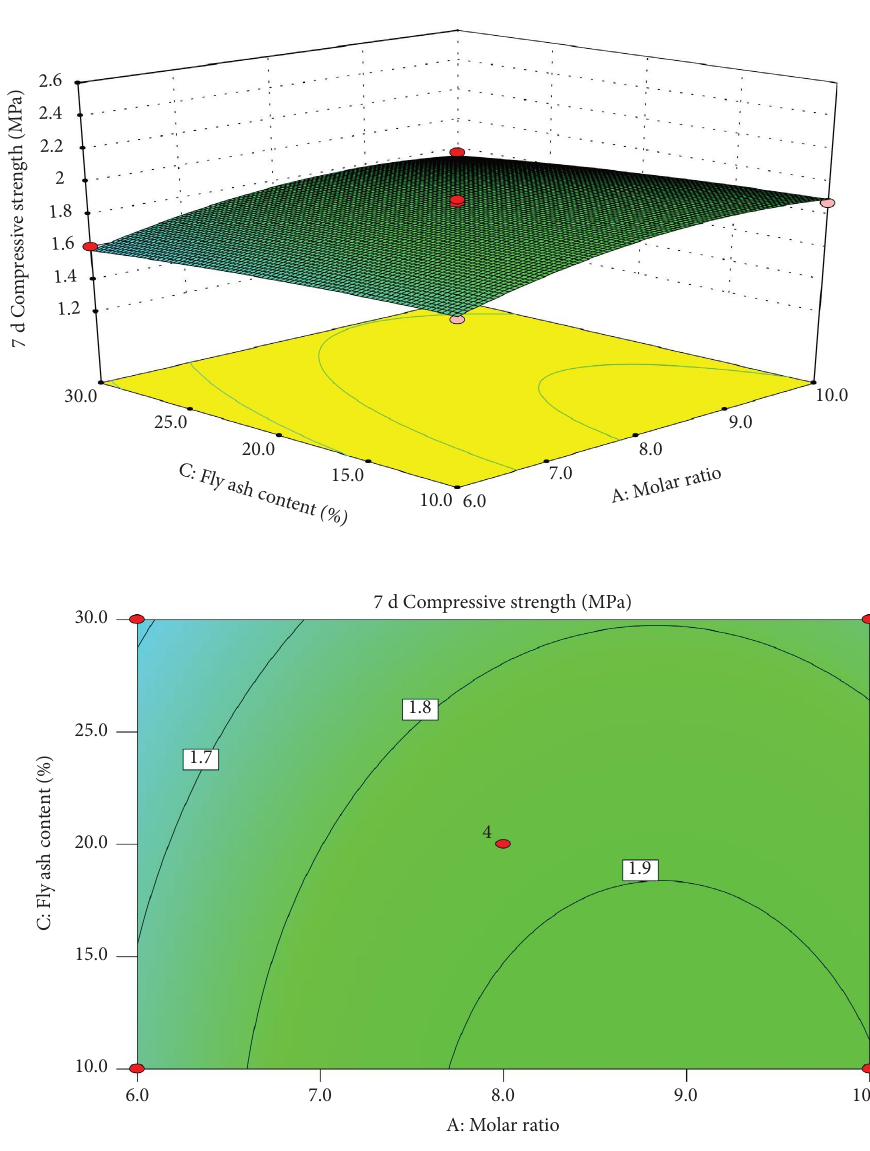
Figure 6: Efect of molar ratio, fy ash content, and their interaction on 7d compressive